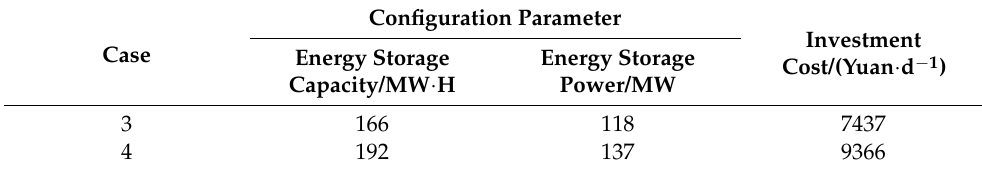
Figure 9. ( a ) Case 3 convergence result; ( b ) Case 4 convergence result. Table 5. Energy storage system capacity configuration